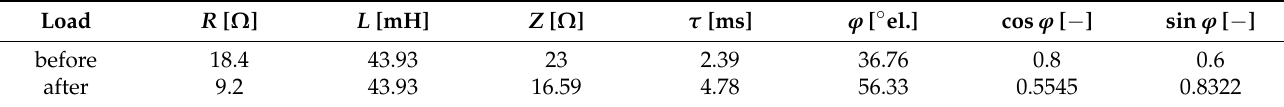
Table 33. Load parameters for steady states before and after load